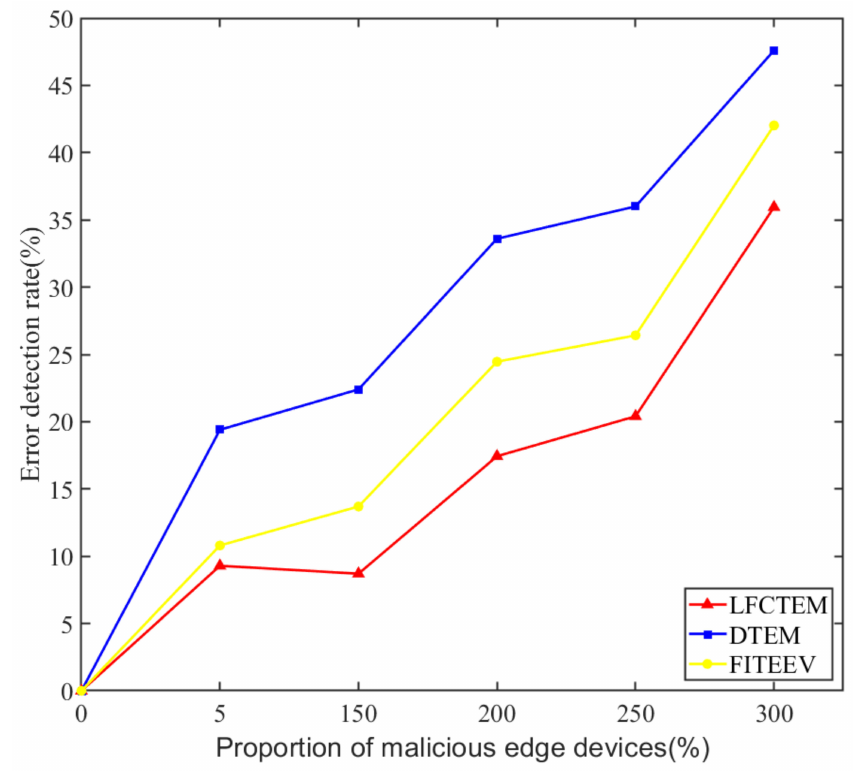
Figure 10. Comparison of error detection rate of malicious edge devices of LFCTEM, DTEM and